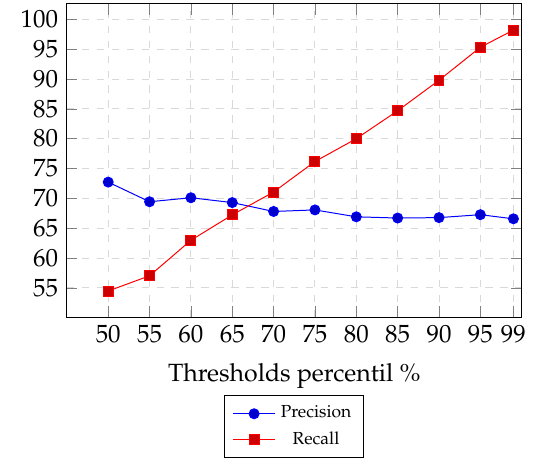
Figure 14. Fourth experiment—isolating class 5 from Y = “Ranking” in Logistic Regression output using